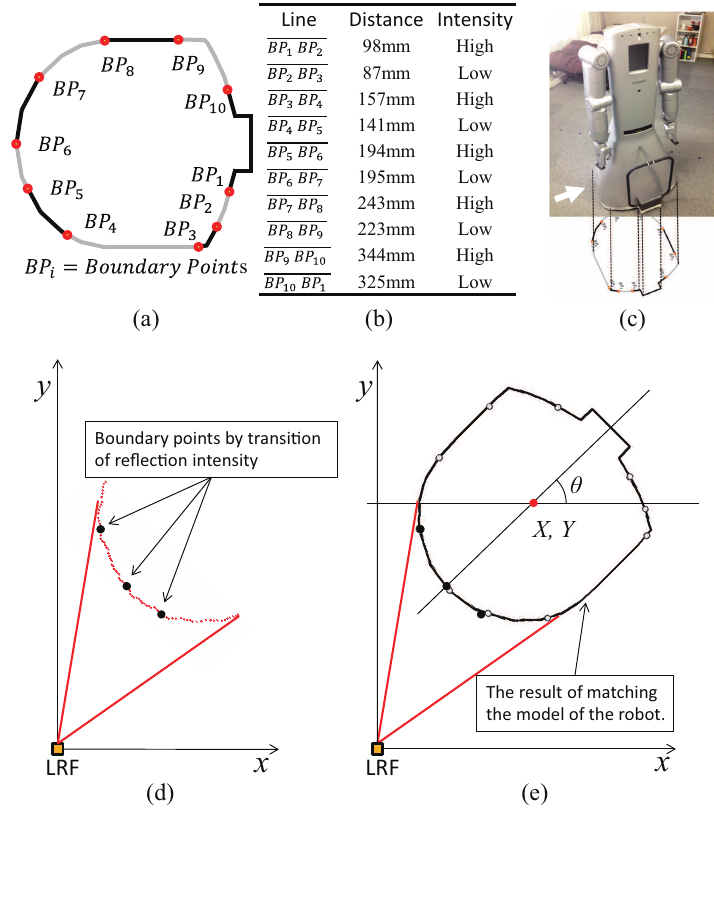
Figure 10. Example for measuring the robot’s pose: ( a ) reflection feature, ( b ) features between points, ( c ) target location, ( d ) laser scan data, ( e ) result of